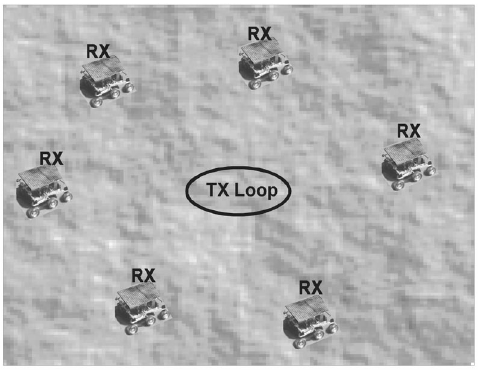
Fig. 3. Rover distributed